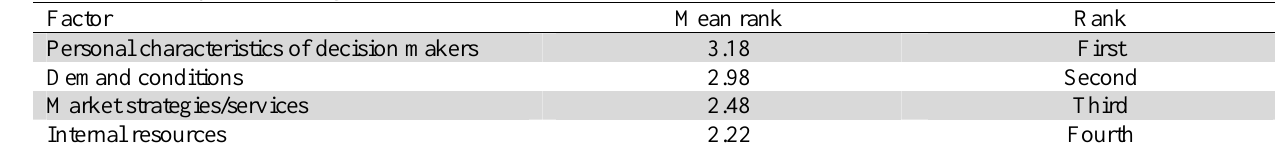
The summary of ranking factors based on Freedman test for